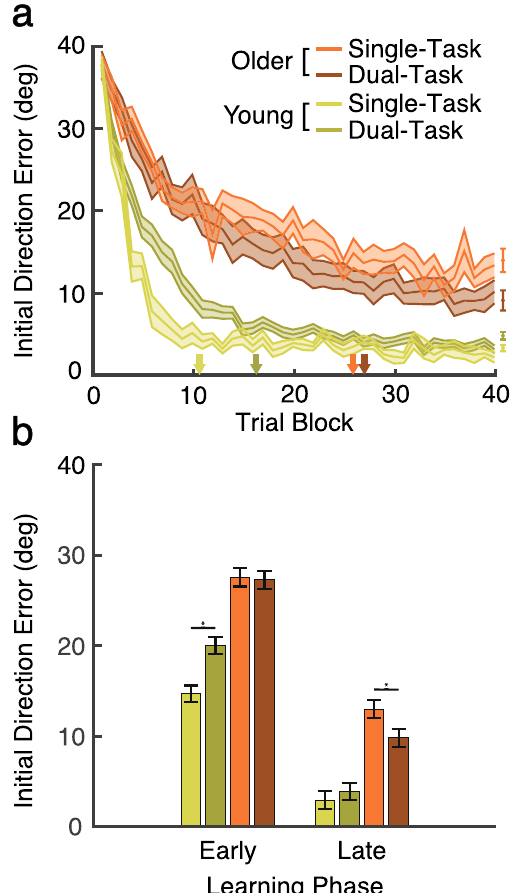
Figure 2. Visuomotor adaptation performance in the learning phase. We compare initial direction errors from young (green) and older (orange) adults across the single task (lighter color) and dual-task groups (darker color). ( a ) Initial direction error. The single dot data points on the far right (after the 40th trial block) indicate the estimated asymptotic reach value for each group. The arrows on the abscissa indicate the trial block at which each group reached asymptotic performance. The ribbons represent between-subjects standard error (SE). ( b ) Mean initial direction error in the early and late learning phases. Error bars indicate standard error